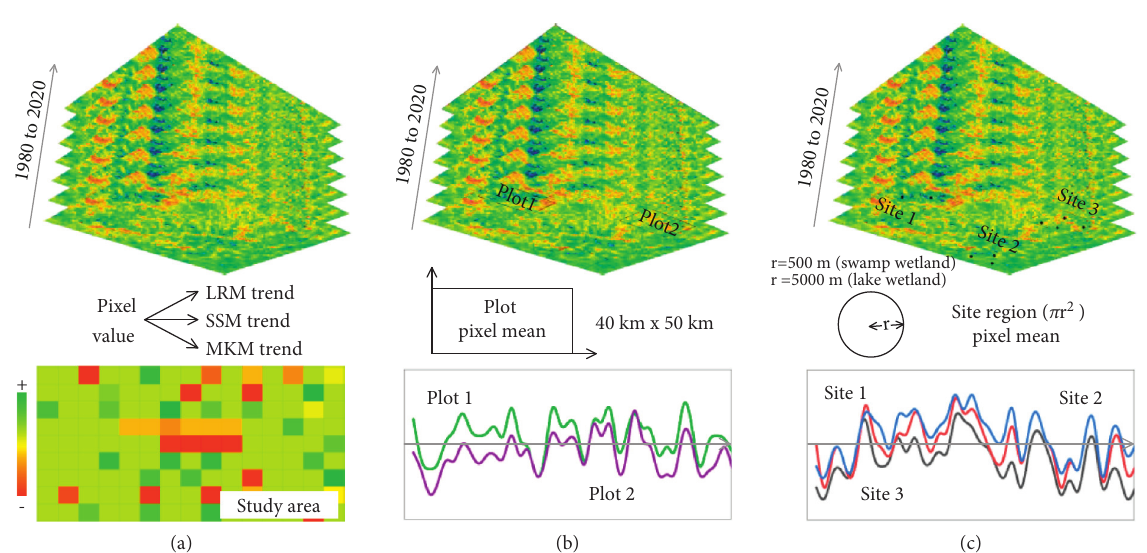
Figure 2: Computing and analyzing principle of the geospatial big data collection in a multiscale. (a) Regional scale: grid of change trend in study area from 1980 to 2000. (b) Plot scale: curve of the factor in the plot from 1980 to 2020. (c) Site scale: curve of the factor in a representative site from 1980 to